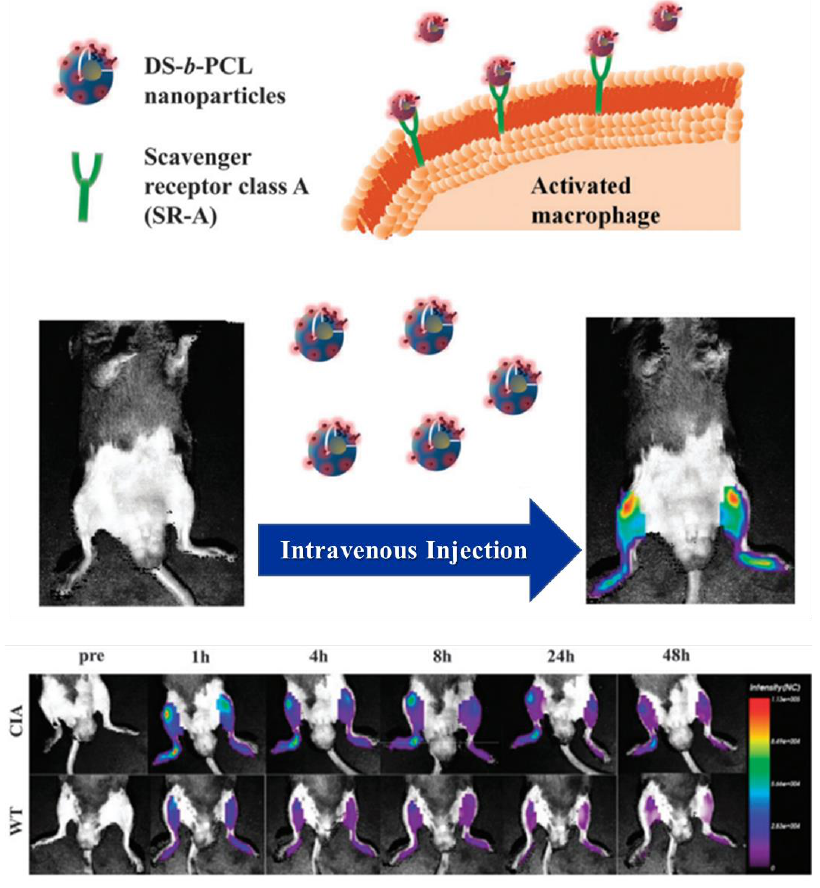
Figure 6. Schematic illustration of DXS-b-PCL nanoparticles for SR-A receptor-mediated targeted imaging of RA. In vivo biodistribution of the nanoparticles in CIA mice. Adapted with permission from ref [73] . Copyright 2013 The Royal Society of Chemistry.